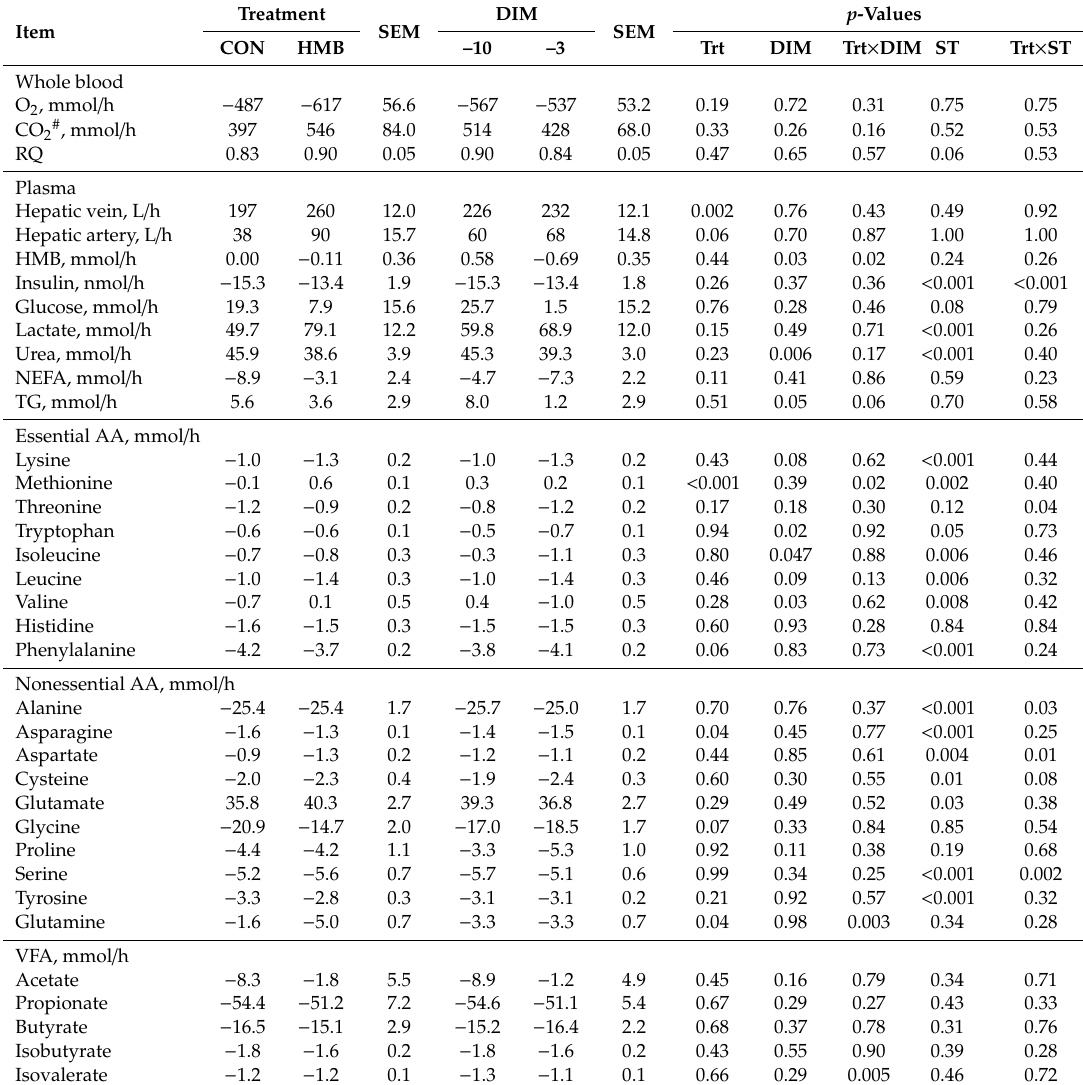
Table 6. Blood and plasma flow, and net hepatic fluxes of gases and metabolites in control (CON) and HMB-supplemented (HMB) sows during late